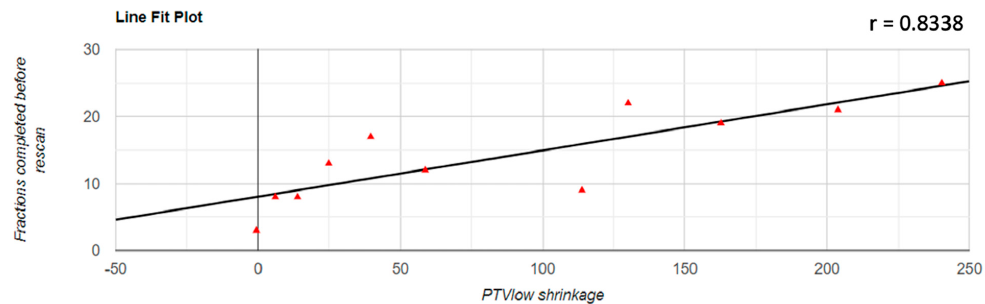
Figure 3. Graphical representation of the PTVlow reduction in correlation with the number of fractions completed before